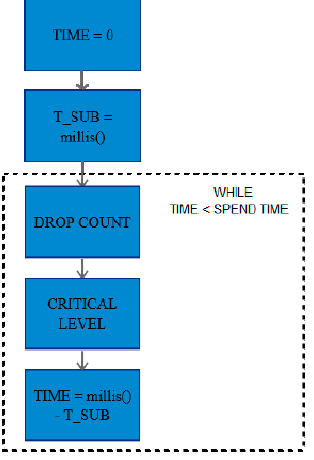
Figure 10. Block diagram of spend time loop.